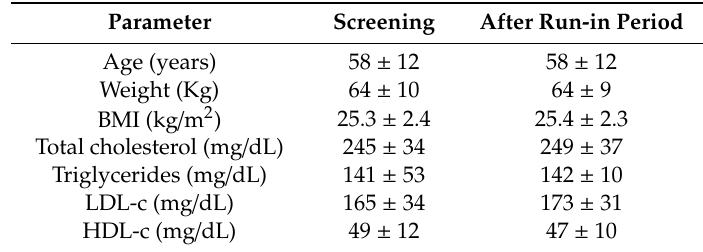
Table 1. Subjects characteristics at baseline.